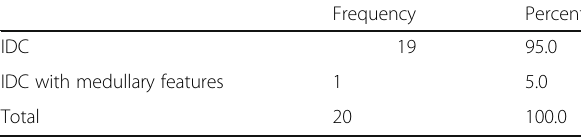
Table 2 Histopathology diagnosis for all